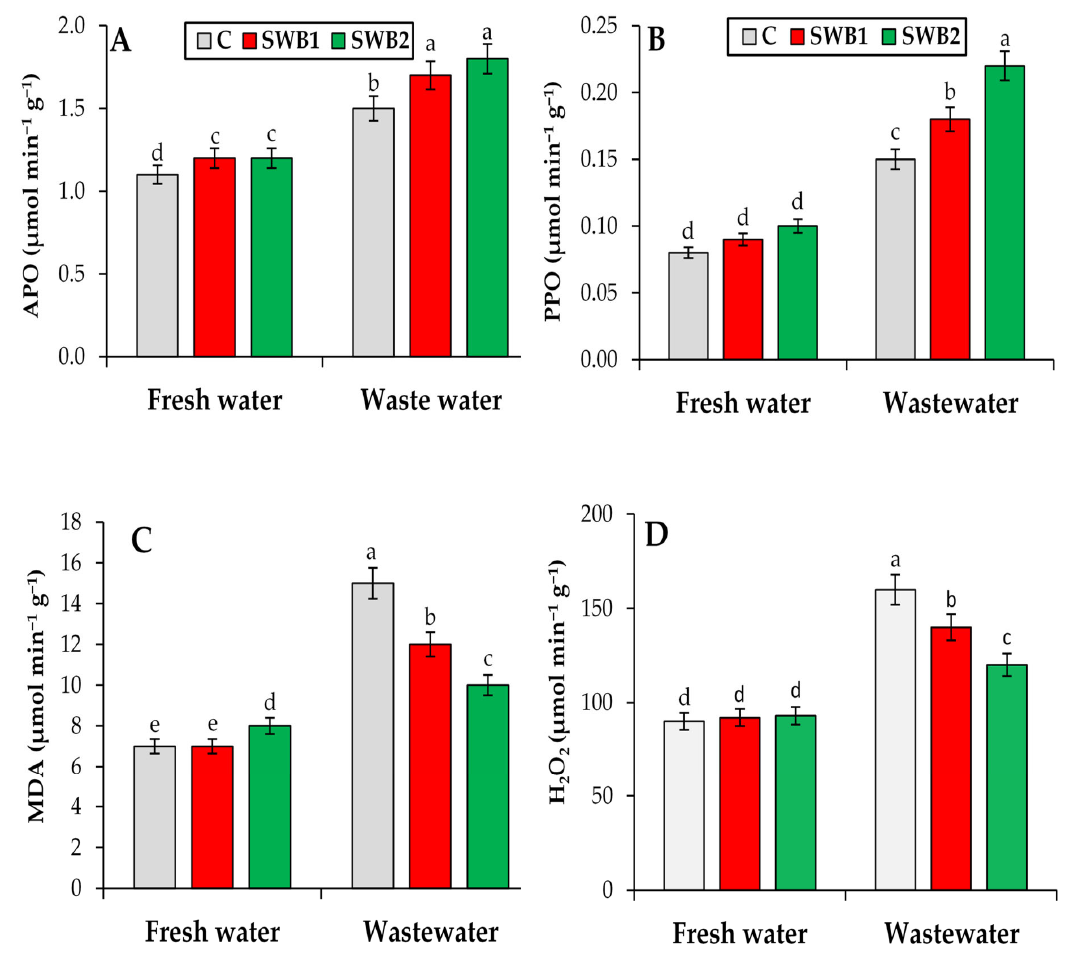
Figure 5. Effect of shrimp-waste-derived biochar (SWB) rates in some biochemicals in quinoa leaves. C, SWB 1 , and SWB 2 are 0, 1, and 2% ( w / w ) of biochar. ( A ) ascorbate peroxidase (APO), ( B ) polyphenol oxidase (PPO), ( C ) malondialdehyde (MDA), and ( D ) hydrogen peroxide (H 2 O 2 ). Means ( ± SD, n = 5) with different letters indicate significant differences.